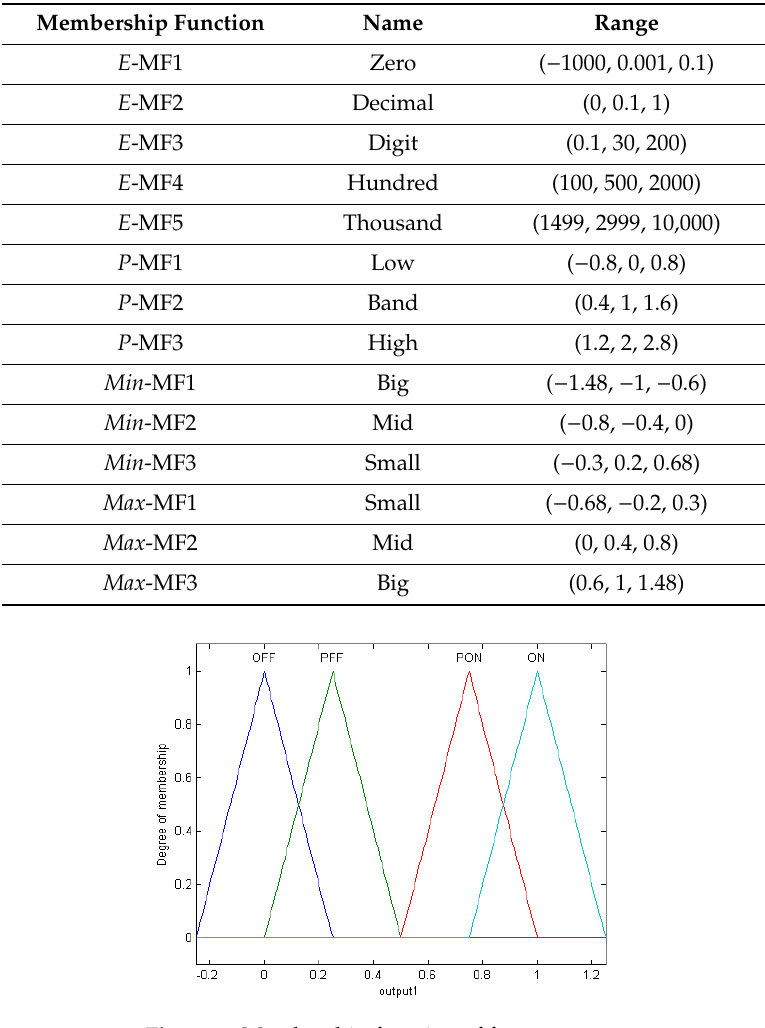
Table 1. Membership functions of E , P , Min , and Max .